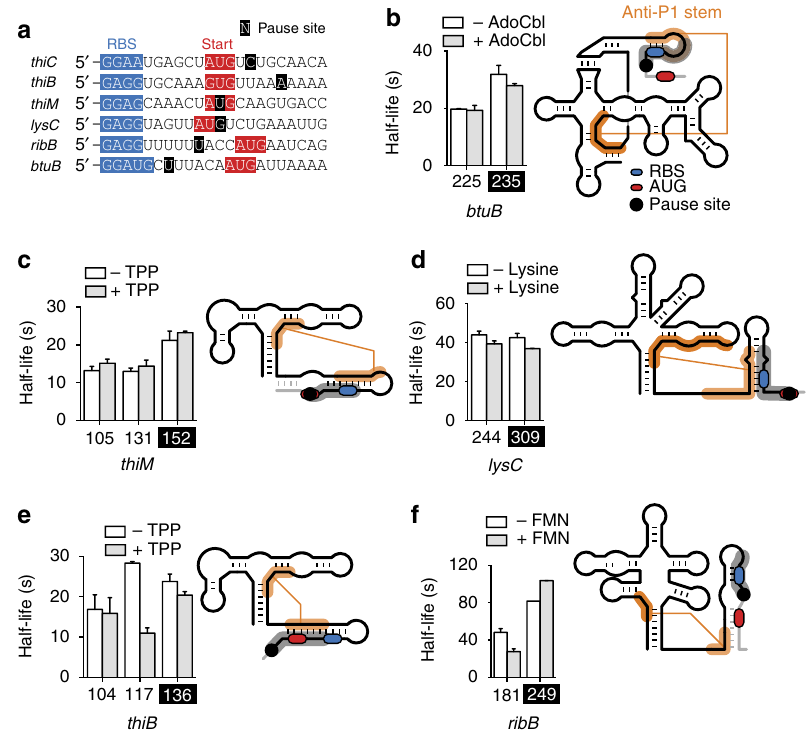
Figure 5 | Transcriptional pause regions in E. coli riboswitches. ( a ) Sequences of E. coli riboswitch start codons. A single position designates each pausing region, centred around positions 187 ( thiC ), 136 ( thiB ), 152 ( thiM ), 309 ( lysC ), 249 ( ribB ) and 235 ( btuB ). Pause sites, RBS and AUG start codon are indicated in black, blue and red, respectively. ( b ) Transcriptional pausing in the btuB riboswitch. A schematic representation of the btuB riboswitch is shown on the right and the 235 pause site is indicated. The grey region represents the section of the riboswitch transcript sequestered by the RNA polymerase when stalled at the pause site, thus allowing anti-P1 formation (shown in orange lines). The RBS and AUG start codon are represented in blue and red, respectively. The pause regions and riboswitch sequence are shown in Supplementary Fig. 11. ( c ) Transcriptional pausing in the thiM riboswitch. A schematic representation of the thiM riboswitch is shown on the right and the pause site at residue 152 is indicated. The colour scheme is identical to the one used in b . The pause regions and riboswitch sequence are shown in Supplementary Fig. 12. ( d ) Transcriptional pausing in the lysC riboswitch. A schematic representation of the lysC riboswitch is shown on the right and the pause site at residue 309 is indicated. The colour scheme is identical to the one used in b . The pause regions and riboswitch sequence are shown in Supplementary Fig. 13. ( e ) Transcriptional pausing in the thiB riboswitch. A schematic representation of the thiB riboswitch is shown on the right and the pause site at residue 136 is indicated. The colour scheme is identical to the one used in b . The pause regions and riboswitch sequence are shown in Supplementary Fig. 14. ( f ) Transcriptional pausing in the ribB riboswitch. A schematic representation of the ribB riboswitch is shown on the right and the pause site at residue 249 is indicated. The colour scheme is identical to the one used in b . The pause regions and riboswitch sequence are shown in Supplementary Fig. 15. The average values of three independent experiments with s.d. s are